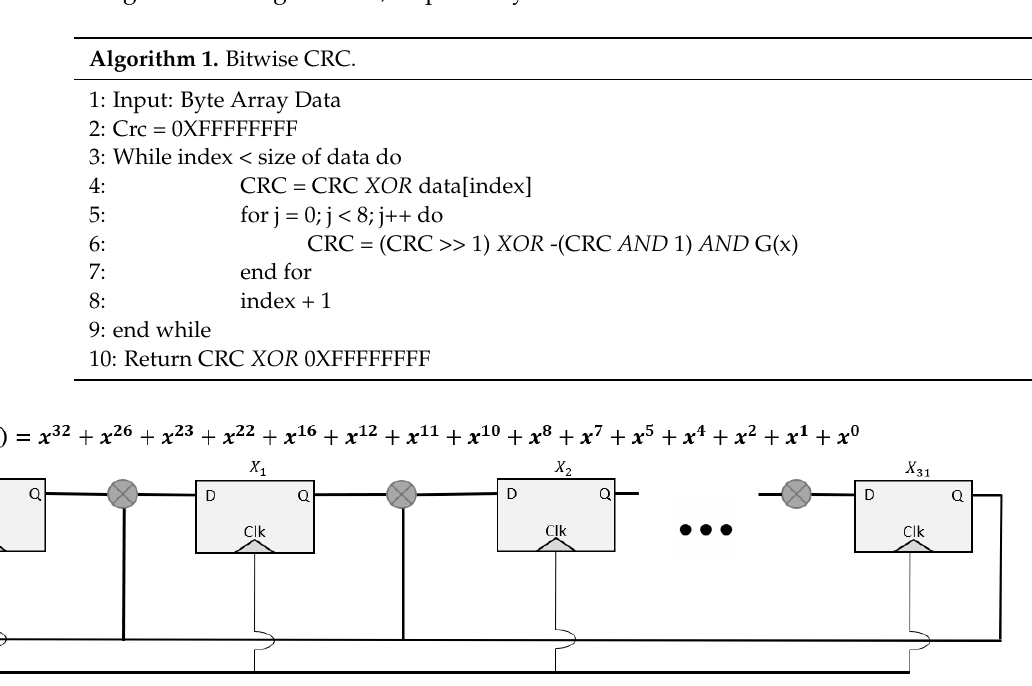
Figure 3. Partial structure of the linear shift register for G(x).